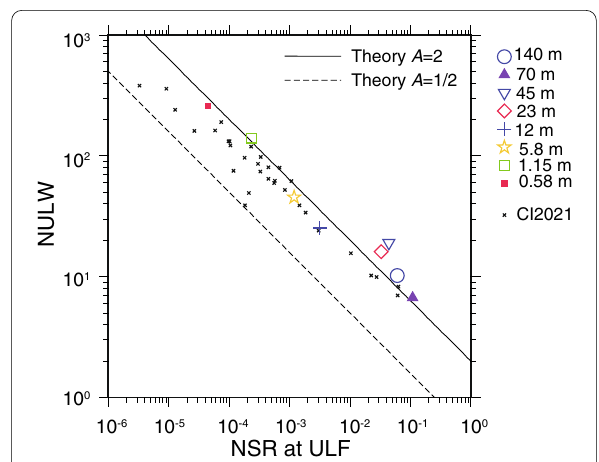
Fig. 10 Relation between the NSR at the ULF and NULW. Theoretical relations (lines) are plotted for reference. The analysis results of CI2021 at Tsukuba, Japan, are also plotted with small crosses